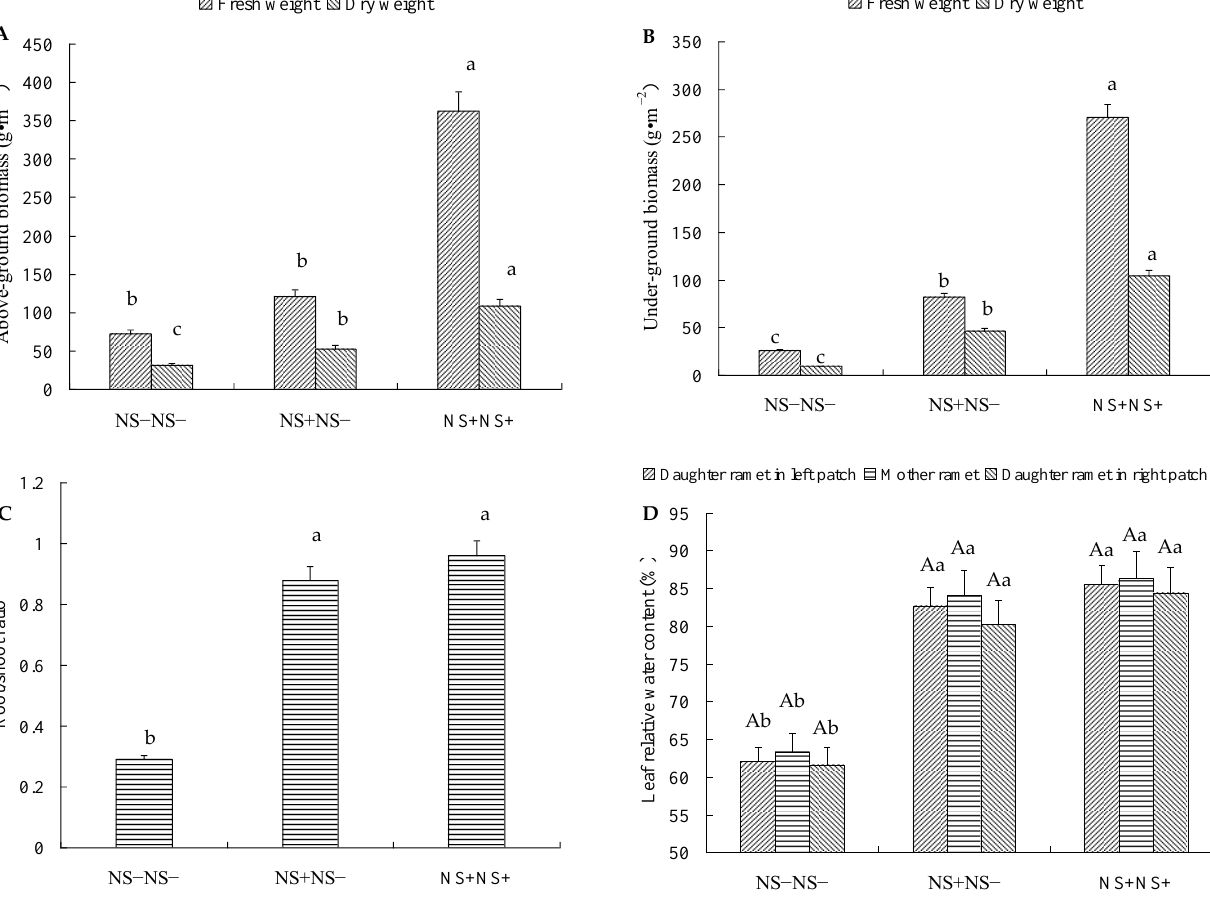
Figure 3. Biomasses ( A , B ), root/shoot ratios ( C ) and leaf relative water contents ( D ) of Kentucky bluegrass under different water treatments. Different capital letters within the same water treatment indicate significant differences at 0.05 level. Different lowercase letters within the same series indicate significant differences at 0.05 level.